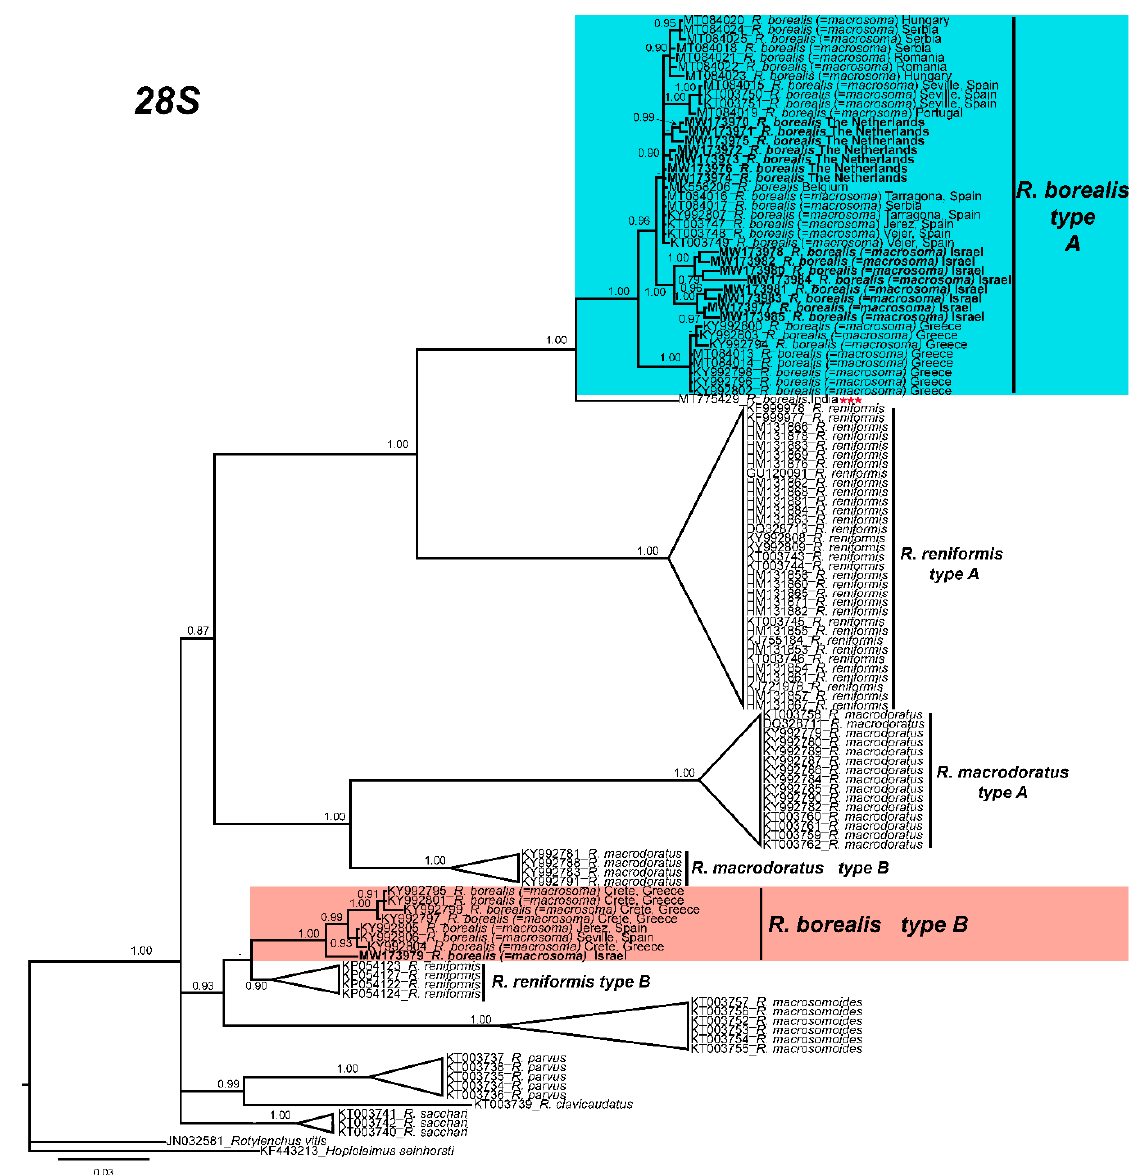
Figure 3. Phylogenetic relationships within the genus Rotylenchulus . Bayesian 50% majority rule consensus tree as inferred from D2 and D3 expansion domains of 28S rRNA sequence alignment under the general time-reversible model of sequence evolution with correction for invariable sites and a gamma-shaped distribution (GTR + I + G). Posterior probabilities of more than 0.70 are given for appropriate clades. Newly obtained sequences in this study are shown in bold. Scale bar = expected changes per site. Some branches were collapsed for improving readability of Rotylenchulus species. *** Sequence that needs to be revised under integrative taxonomical approaches.